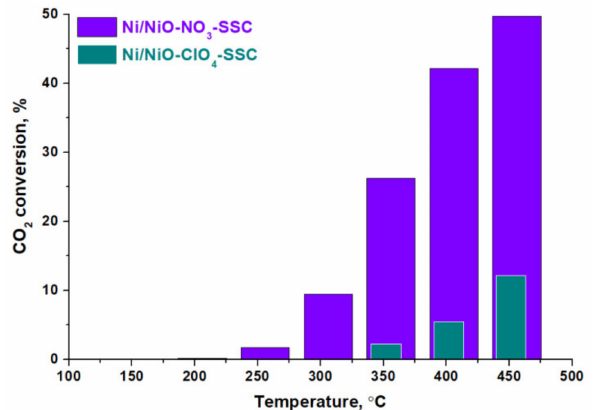
Figure 10. CO 2 conversion during the activation of Ni/NiO-NO 3 -SSC and Ni/NiO-ClO 4 -SSC at different temperatures in the reaction medium (H 2 :CO 2 :Ar = 16:4:80).